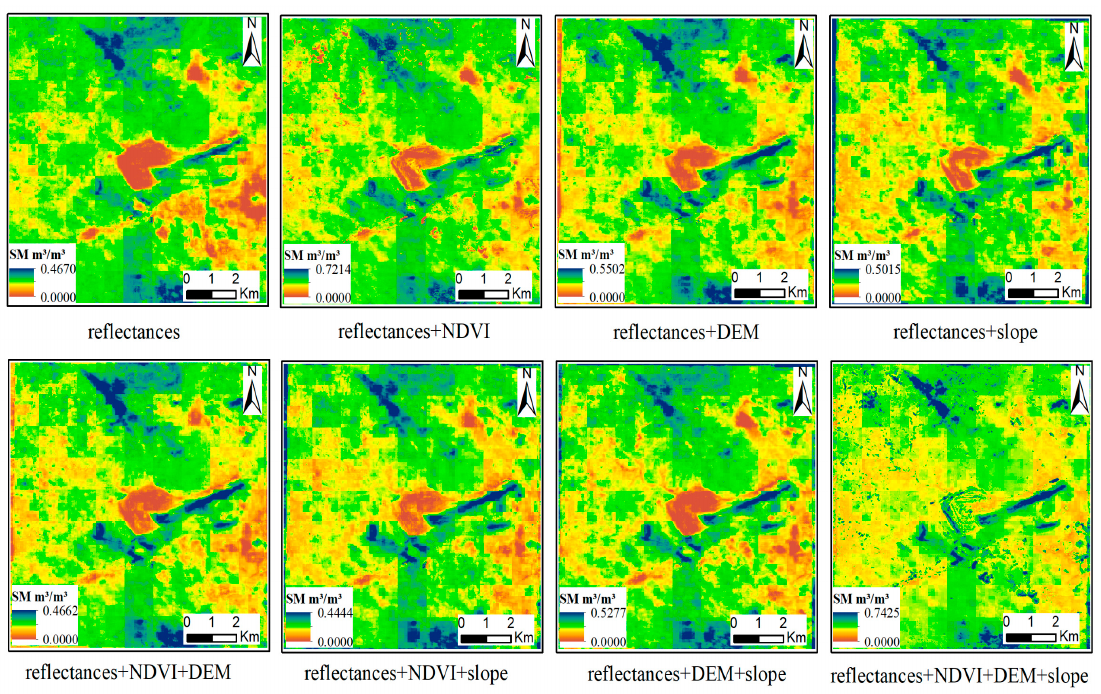
Figure 9. The downscaled SMs derived from 1 km SPL2SMAP_S SM products on 14 May 2021.